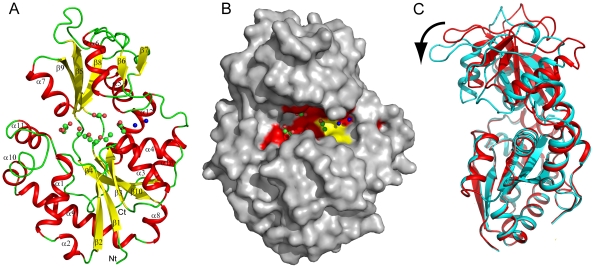
CA3427 structures.A) 2x7p is represented with alpha helices in red and beta-sheet in yellow. Secondary structures are numbered along the protein sequence. Carbon dioxide, glycerol and PEG molecules are in ball and sticks with green carbon and red oxygen atoms. 2 Water molecules are represented as blue spheres. B) Surface representation of the open conformation, 2x7p. The strictly conserved residues in the groove are colored in red and residues with conserved properties are marked in yellow. Carbon dioxide, glycerol and carboxyl molecules are in ball and sticks with green carbon and red oxygen atoms. Two water molecules are represented as blue spheres. C) The two conformations (2x7q: cyan, 2x7p: red) are superposed on domain I (bottom). The venus flytrap motion is illustrated by a black arrow (see Movie S1 for an animated view).